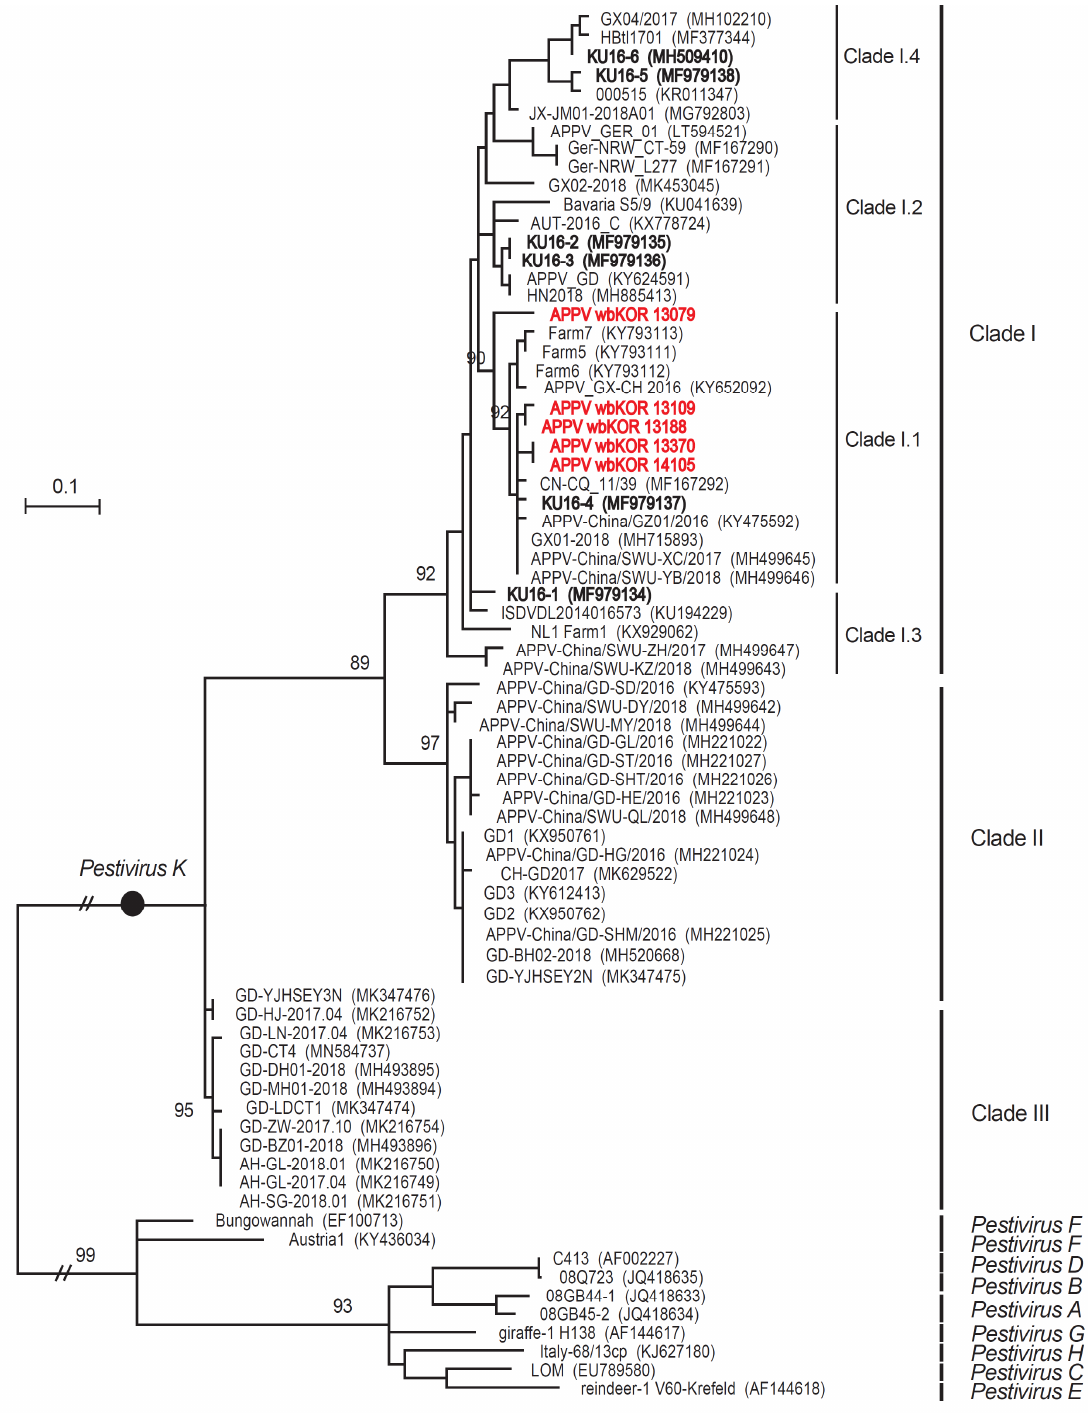
Figure 4. ML tree of South Korean wild boar APPV, based on Npro sequences. The phylogenetic tree (Log L: − 5113.82) was constructed using the ML method (based on the Tamura–Nei model), with bootstrap analysis ( n = 1000). The complete Npro sequences of five APPV detected in South Korean wild boars were compared with 69 reference sequences (including ten outgroup strains: pestiviruses A–H ).